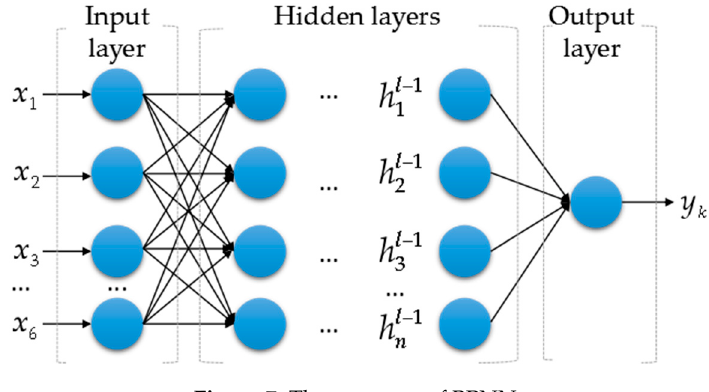
Figure 7. The structure of BPNN.